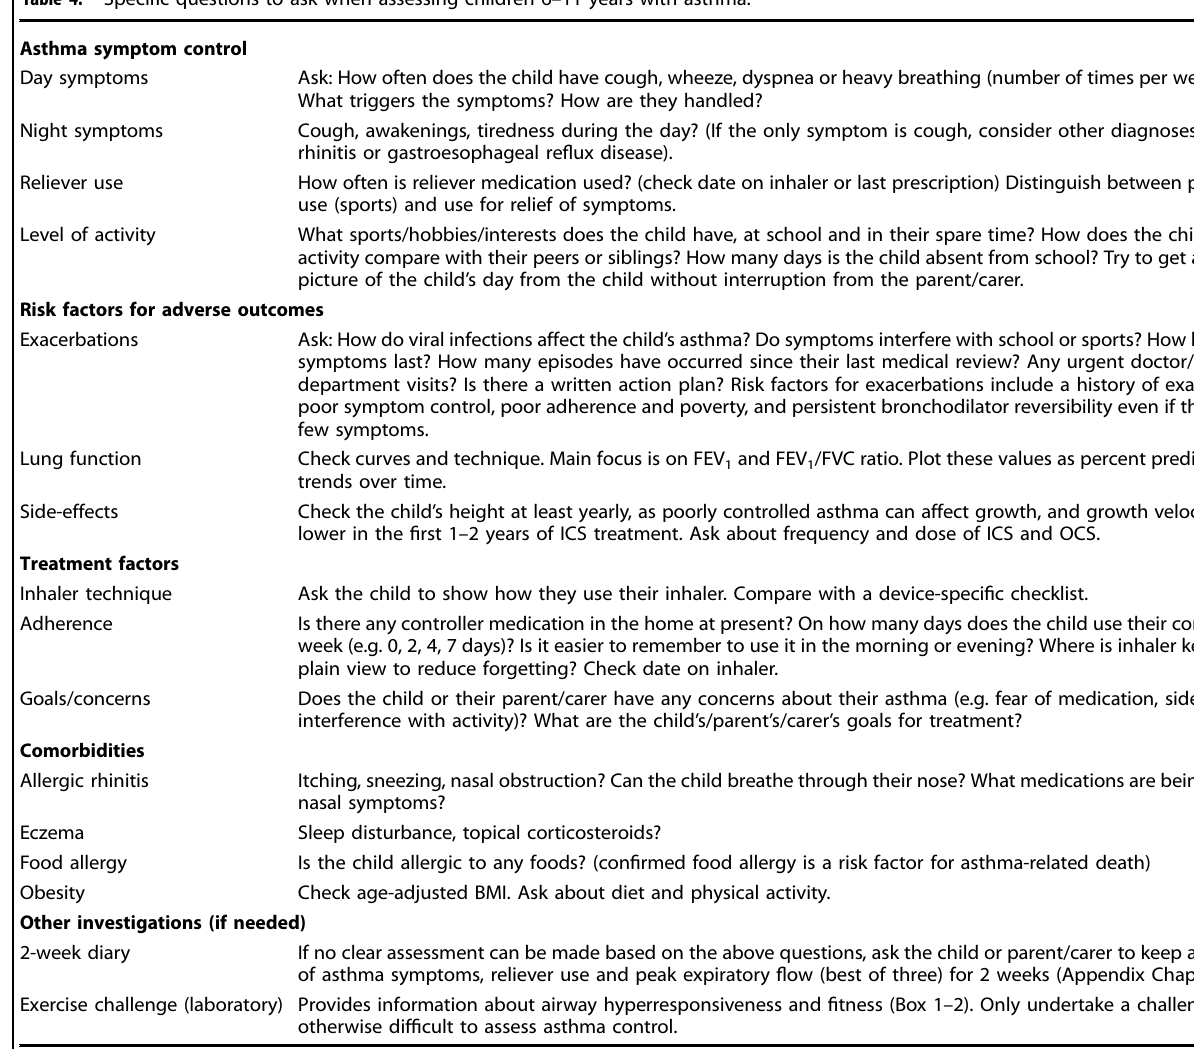
Table 4. Speci fi c questions to ask when assessing children 6 – 11 years with